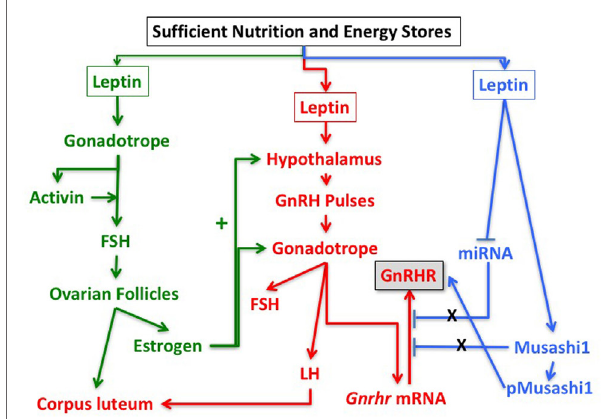
FiGUre 5 | Pathways in the reproductive axis and the critical leptin targets that must be activated for reproductive competence. The pathway in green is proposed based on the evidence that leptin stimulates activin mRNA ( Figure 2 ) and that activin mRNA is reduced in leptin receptor (LEPR)-null gonadotropes (33). It is also based on evidence that restoration of LEPR in LEPR-null gonadotropes results in elevated follicle-stimulating hormone (FSH) (101) as activin is important for FSH synthesis. We propose that this well-established FSH-driven pathway provides the stimulation to the follicle that results in a rise in estradiol needed early in the cycle to promote responses from GnRH neurons and gonadotropes. The red pathway is focused on the well-established circuitry in which leptin regulates LEPR- target neurons in the hypothalamus to stimulate GnRH neurons. It is based on evidence from key studies showing that restoration of LEPR in the PMV improves fertility (50, 82). The pathway shows that GnRH pulses are needed for transcription of Gnrhr mRNA as well as transcription and translation of LH and FSH. The blue pathway is based on our recent studies showing that mice lacking LEPR in gonadotropes are subfertile (33) or infertile ( Figure 1 ; table 1 ) and have significantly reduced gonadotropin releasing hormone receptor (GnRHR) proteins, but not mRNA levels (33). We hypothesize that leptin plays a direct post-transcriptional role in de-repressing mRNA translation by inhibiting miRNAs and/or MSI1, which then allows activation of Gnrhr mRNA